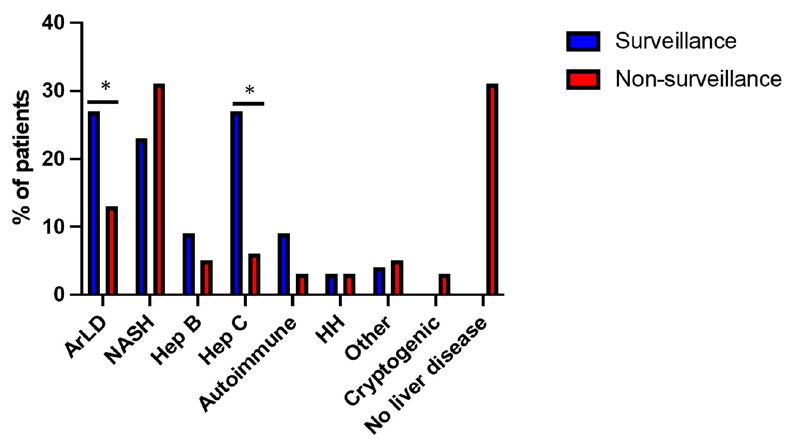
Figure 3. Aetiology of liver disease in surveillance and non-surveillance groups. Alcohol-related liver disease (ArLD), non-alcoholic steatohepatitis (NASH), hepatitis B (Hep B), hepatitis C (Hep C), hereditary haemochromatosis (HH), other—Alagille syndrome, glycogen storage disorder, congenital heart disease. * p ≤ 0.05 (chi-square test).